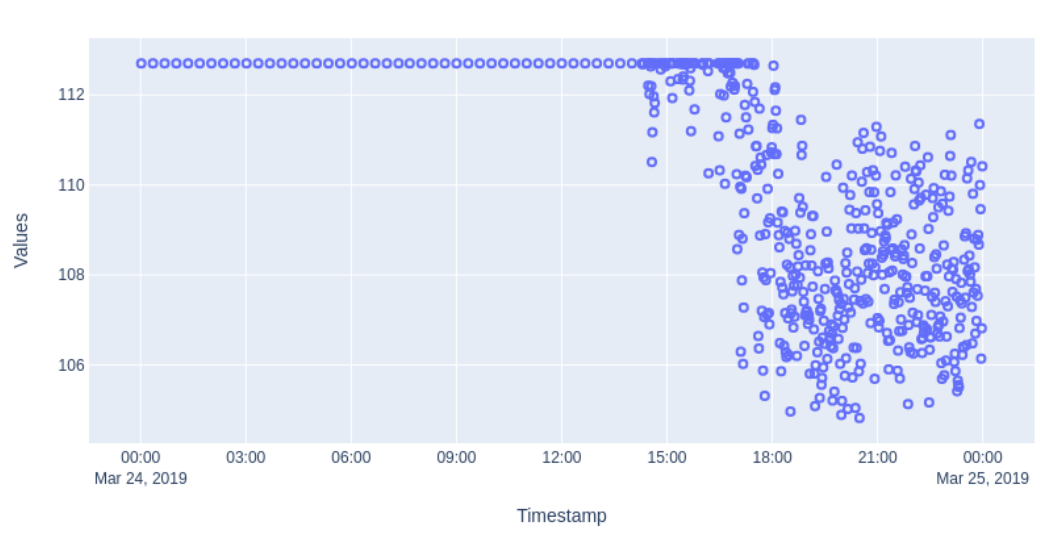
Figure 9. Original data of the feature with id 14 from Figure